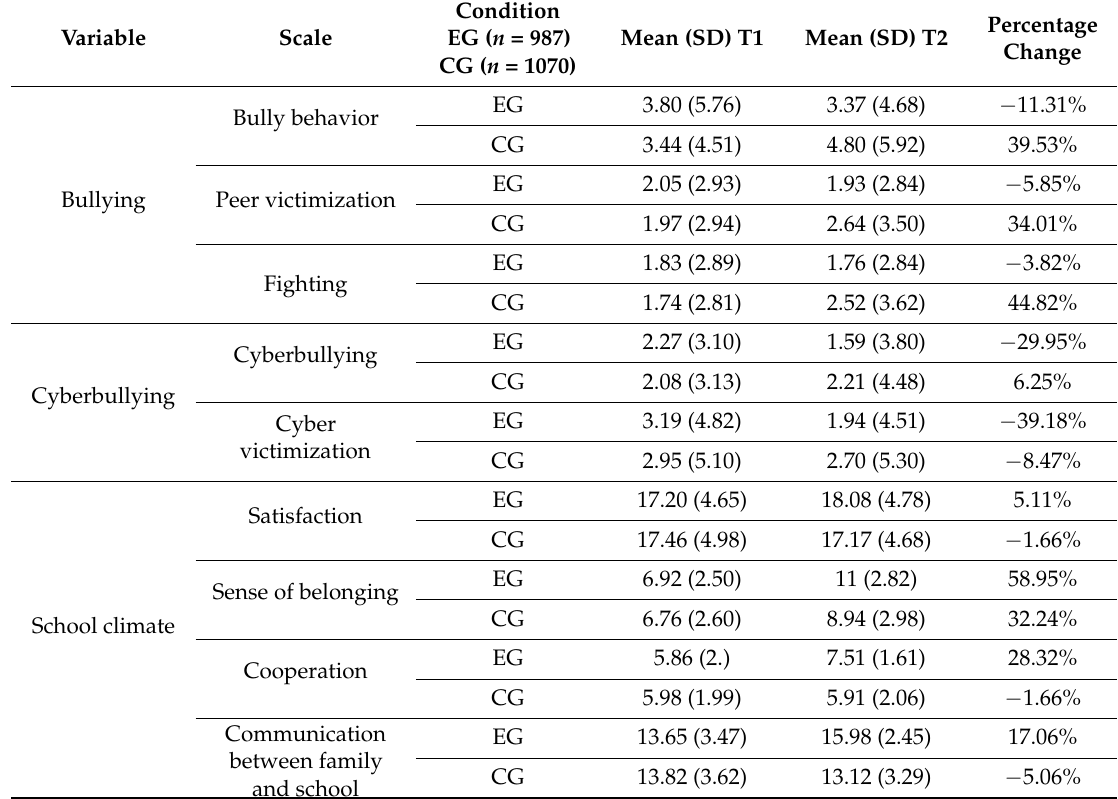
Table 1. Mean and Standard Deviation (T1-T2) and percentage change by